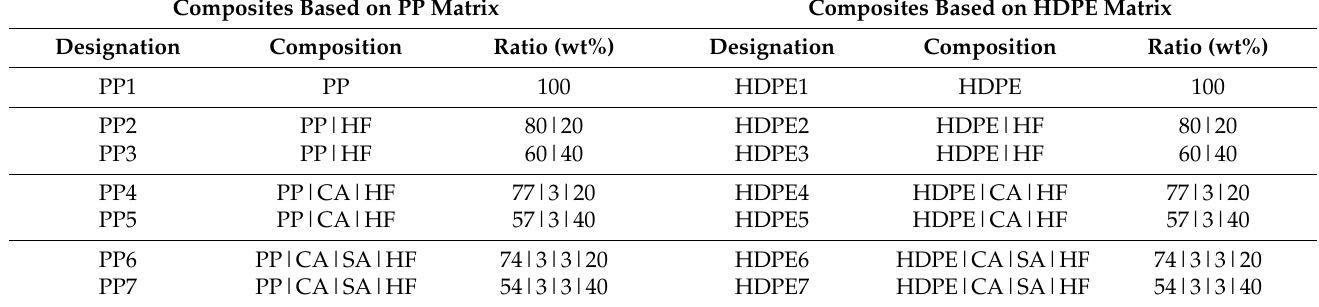
Table 4. Composite